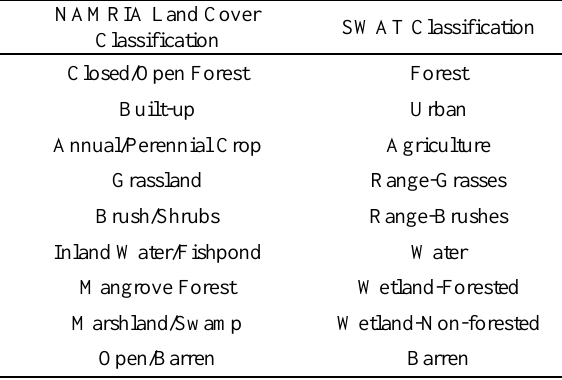
Table 2 . Reclassification of land cover classes for SWAT Modelling.